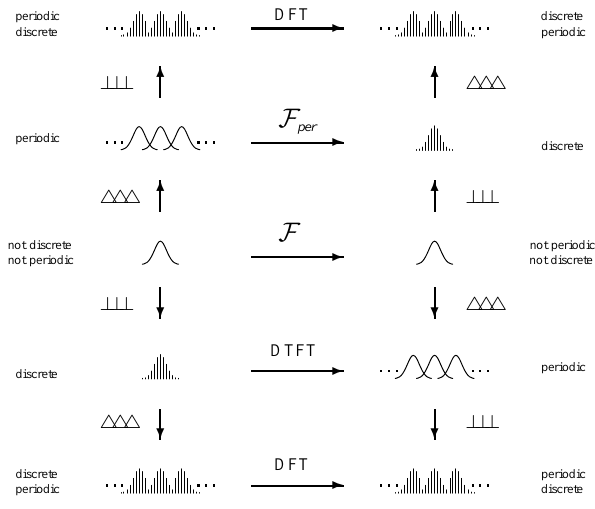
Fig. 1. Four Fourier transforms: , , DTFT and DFT, linked via Figure 1. Four Fourier transforms and the links and between them. In the tempered F F per operations of discretization and periodization . All four transforms ⊥⊥⊥ (cid:52)(cid:52)(cid:52) ⊥⊥⊥ (cid:3)(cid:3)(cid:3) distributions sense, all four transforms , , DTFT and DFT reduce to only one Fourier transform, coincide with in the generalized functions sense. F F per F the Fourier transform on tempered